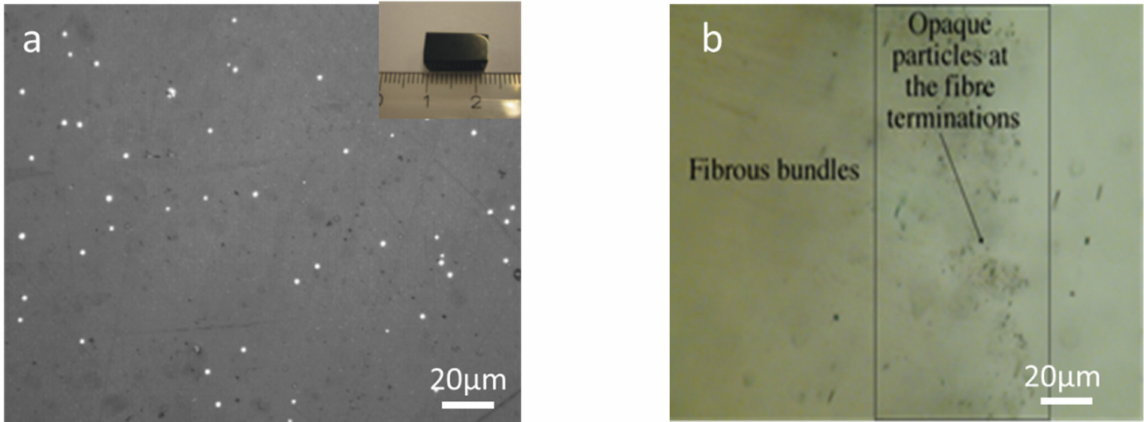
Figure 2. Optical micrographs were showing the presence of ( a ) La silicides (white spots) in nitrogen-enriched La − Si − O − N glass and a polished glass piece of (inset). ( b ) Fibrous bundles in La − Si − O − N glass.